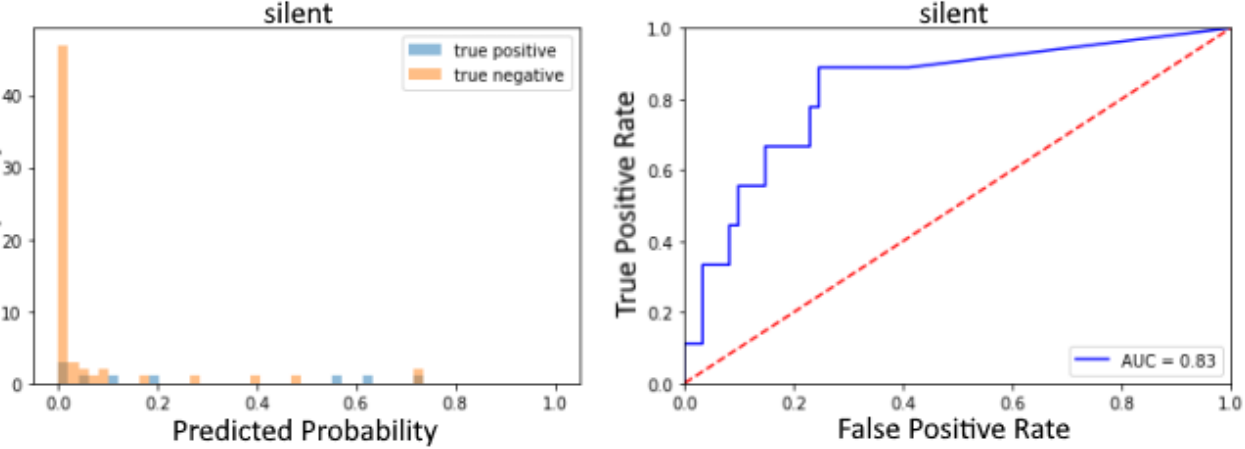
Figure 11. Results | Probability Histogram and ROC-Curve for the class silent corticotroph adenoma of the model that was trained on an undersampled training set in which all four classes were evenly distributed.